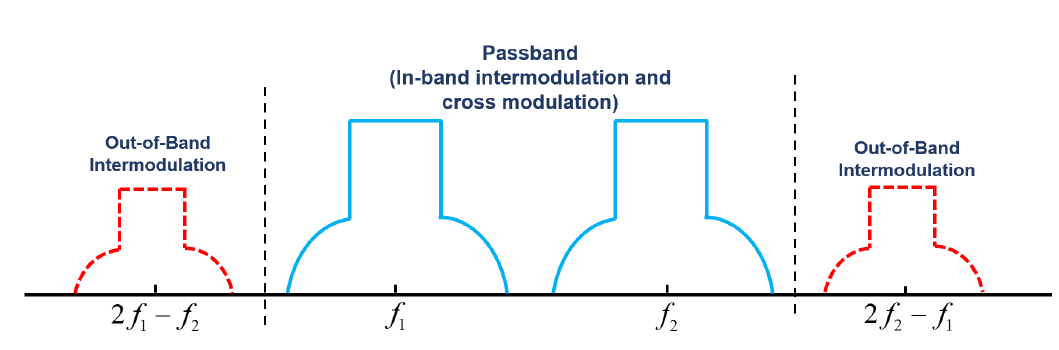
Figure 1. Output power spectrum of dual-band signals including out-of-band